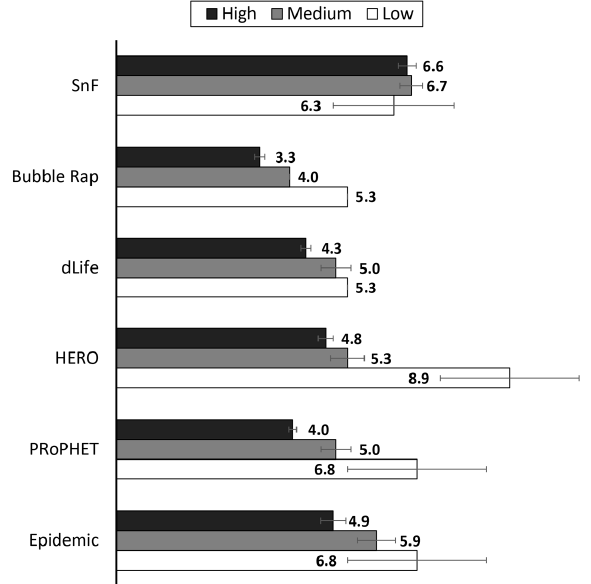
Figure 2. The percentage of nodes that partake in forwarding up to 25% of the total number of messages in the network under low, medium, and high degrees of spatial locality.